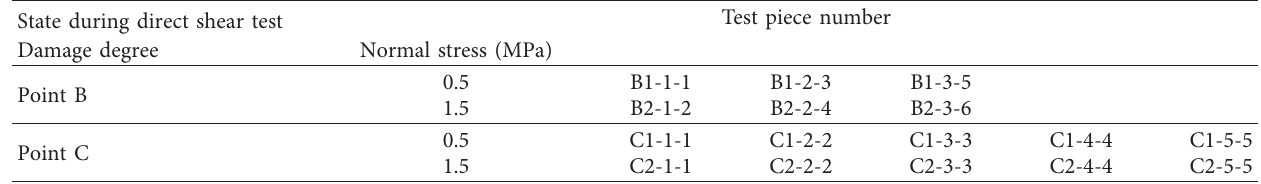
Table 2: Summary of specimen numbers.